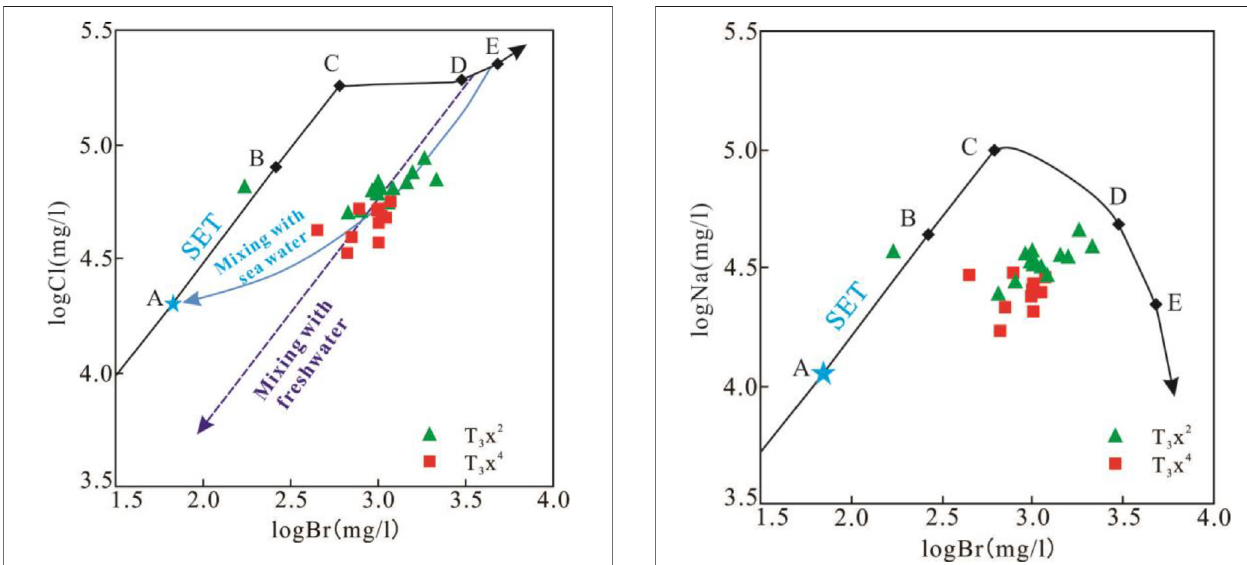
FIGURE 5 | Relationship between the logBr-logNa and SET of the formation water in the middle section of the western Sichuan Depression. Notes: SET and the positions of points A, B, C, D, and E refer to Carpenter (1978). The meanings of points A, B, C, D, and E are the same as in Figure 4